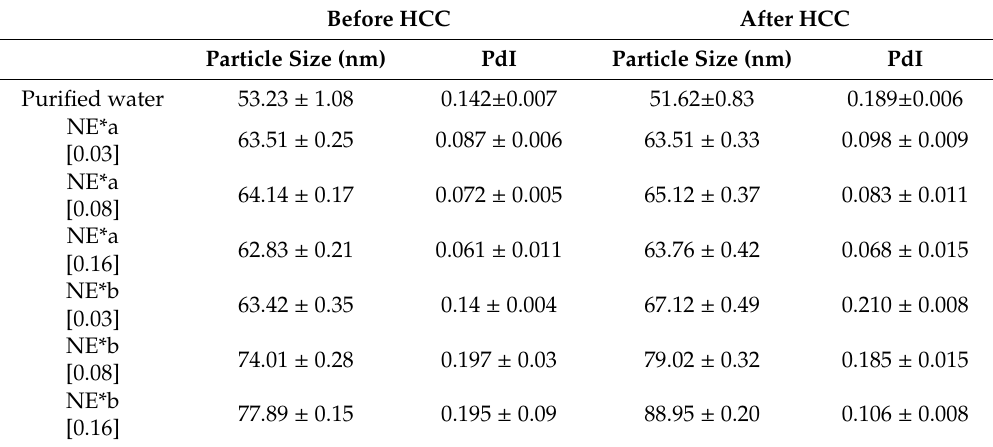
Table 5. Particle size (nm) and PdI of NE*s (nanoemulsions produced with NaHCO 3 and NaCl) before and after the HCC. Before HCC After HCC Particle Size (nm) PdI Particle Size (nm)